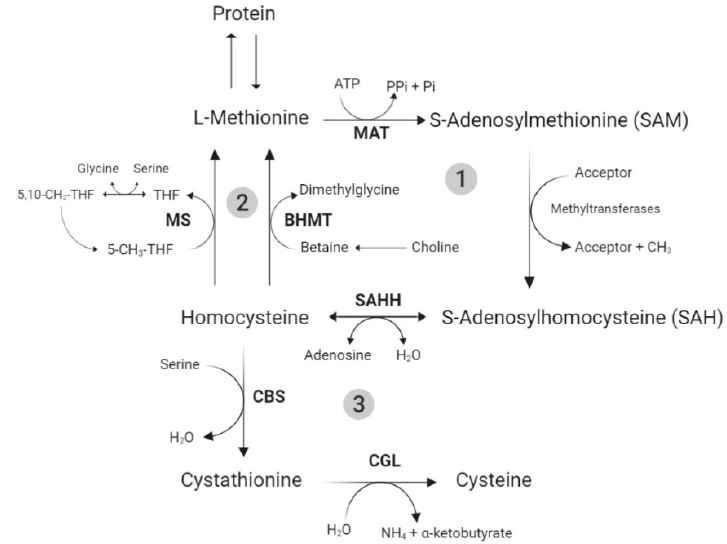
Figure 2. Methionine metabolism. 1—transmethylation, 2—remethylation, 3—transsulfuration.